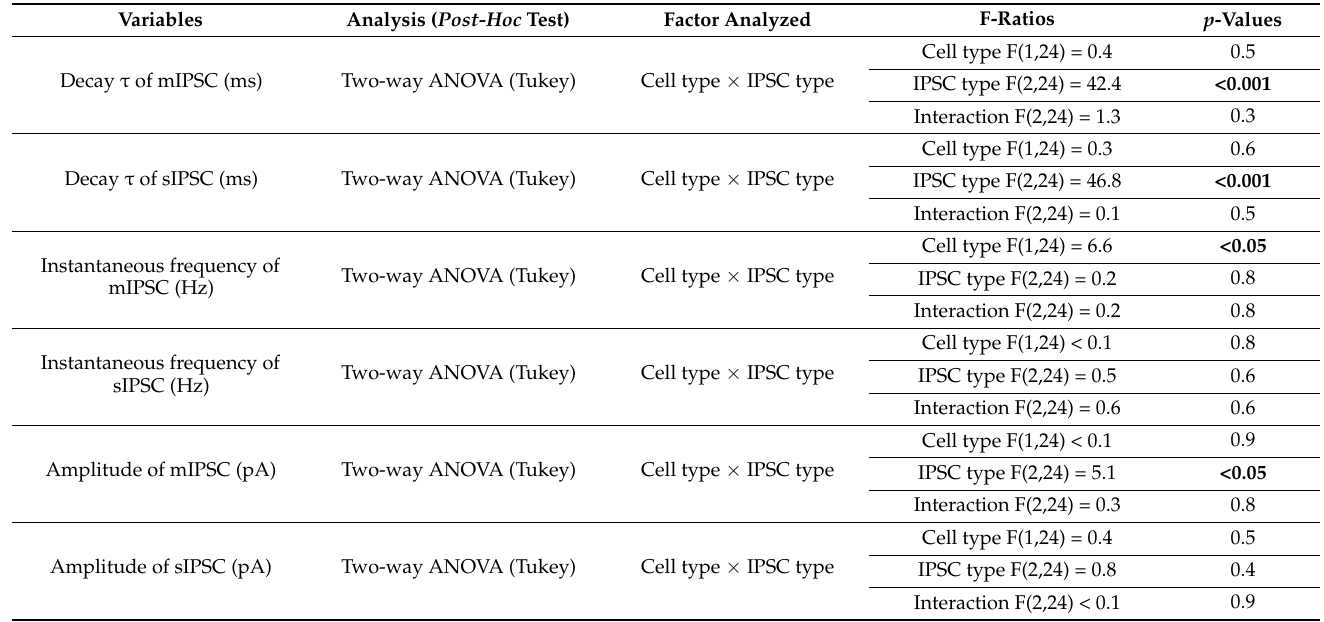
Figure 2. Proportions of kinetically defined sIPSC and mIPSCs recorded from lamina IIi PKC γ + and PKC γ − interneurons. Bar histogram showing the mean ± SEM of proportions (%) of the different kinetically defined (fast monoexponential, slow monoexponential, and biexponential) spontaneous (sIPSC) or miniature inhibitory postsynaptic currents (mIPSC) recorded from lamina II i PKC γ + ( n = 10) or PKC γ − ( n = 10) interneurons. The comparison between groups was made using two-way ANOVA followed by Tukey’s post-hoc test. * p < 0.05. Table 2. Summary of statistical